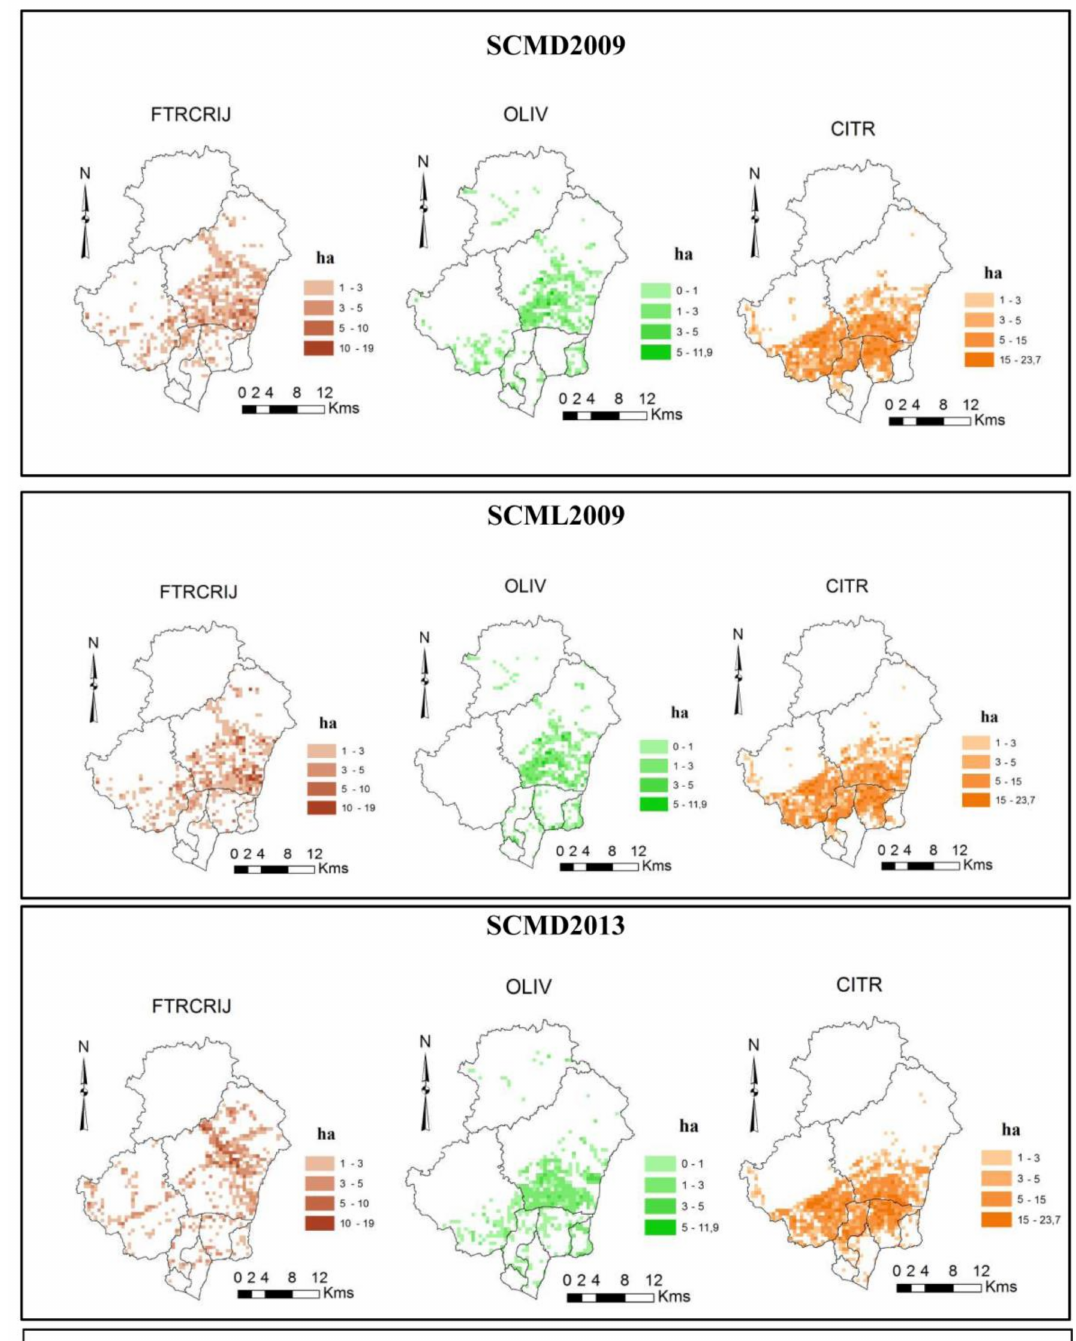
Figure 5. The examples of the data disaggregation results in the Silves municipality; source: model